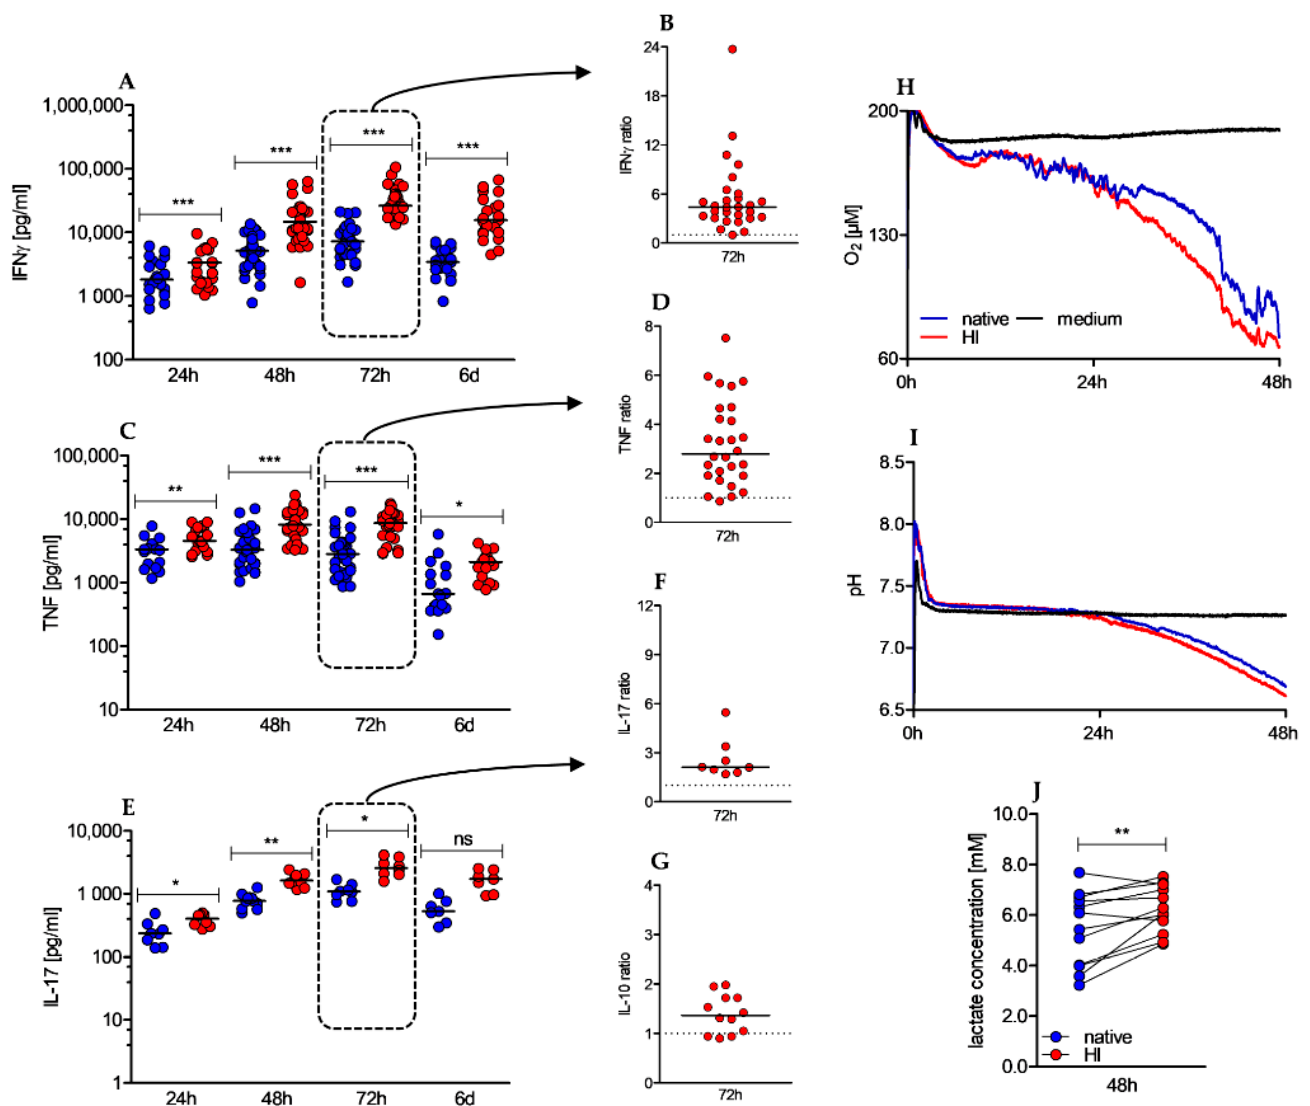
Figure 4. Heat-inactivated serum promotes cytokine secretion and increases O2 consumption and lactate secretion. ( A – G ) Cytokine levels in culture supernatants were determined by ELISA after 24 h, 48 h, 72 h, and 6 d. Depicted graphs show absolute values of IFN γ ( A ), TNF ( C ) and IL-17 ( E ) over time and the ratio of IFN γ ( B ), TNF (D), IL-17 ( F ), and IL-10 ( G ) in HI to native serum conditions after 72 h of stimulation; (shown is the median, IFN γ 24 h n = 23, 48 h n = 43, 72 h n = 29 (native)/28 (HI) and 6 d n = 21; TNF 24 h n = 17; 48 h n = 37 (native)/36 (HI); 72 h n = 28; 6 d n = 17; IL-17 24 h n = 8; 48 h n = 11; 72 h n = 8; 6 d n = 7; IL-10 72 h n = 12, Wilcoxon test, * p < 0.05/4; ** p < 0.01/4; *** p < 0.001/4, ns not significant). To analyze O2 consumption ( H ) and extracellular pH levels ( I ), (H–I) 0.8 × 106 CD4+ T cells were anti-CD3/CD28 bead stimulated for 48 h in a PreSense Sensor Dish plate. One representative experiment is shown. ( J ) Supernatants of stimulated CD4+ T cells were withdrawn after 48 h of stimulation to enzymatically measure extracellular lactate concentrations in native and HI serum cultures ( n = 12, Wilcoxon test; ** p < 0.01).